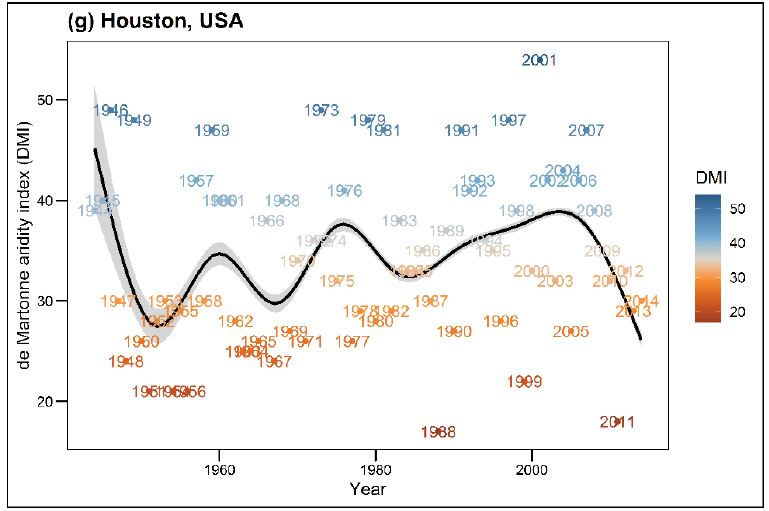
Figure A1. Annual de Martonne Indices (DMI) over the entire periods for each city. High DMI values indicate humidity, i.e., cool and moist conditions, low DMI values indicate aridity, i.e., dry and warm conditions. The black line shows the smoothed mean DMI course through the years using gam algorithm.